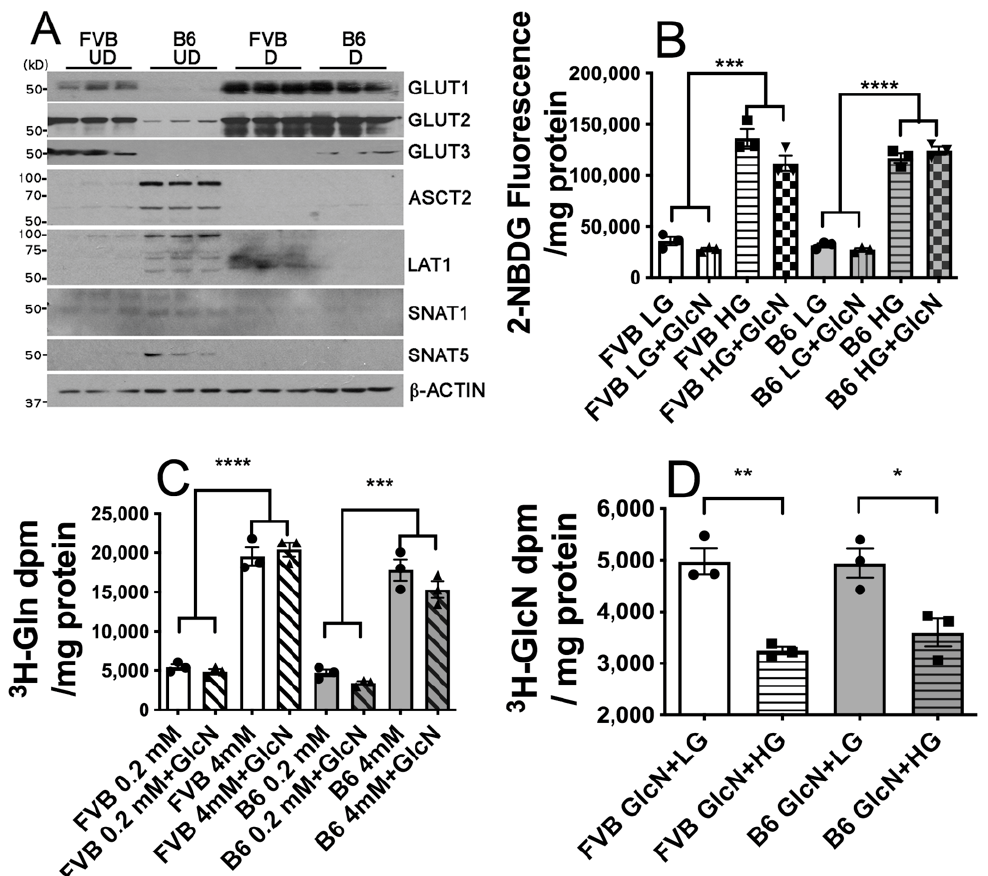
Figure 2. Transport of the hexosamine biosynthetic pathway substrates glucose, glutamine, and GlcN by FVB and B6 LG-ESC. ( A ) Immunoblot analysis of steady state levels of the glucose transporters, GLUT1 (~55 kDa), GLUT2 (~57 kDa), and GLUT3 (~47 kDa), and the glutamine transporters, ASCT2 (~56 kDa), LAT1 (~55 kDa), SNAT1 (~48 kDa), and SNAT5 (~52 kDa), and β -ACTIN (~42 kDa) as a loading control, from three replicate culture dishes of undifferentiated (UD) or differentiating neuronal precursors (D) from FVB or B6 LG-ESC. ( B ) Transport of 5 (LG) or 16 mmol/L (HG) fluorescent 2-deoxy-D-glucose (2-NBDG) in the presence or absence of 0.8 mmol/L GlcN. ( C ) Transport of 0.2 or 4 mmol/L 3 H-glutamine (Gln) in the presence or absence of 0.8 mmol/L GlcN. ( D ) Transport of 0.8 mmol/L 3 H-GlcN in the presence or absence of 5 (LG) or 16 (HG) mmol/L glucose. Data shown are means ± SEM and were analyzed by two-way ANOVA followed by Tukey’s multiple comparisons test ( B , C ) or Student t test ( D ). * p < 0.05; ** p < 0.01; *** p < 0.001; **** p <